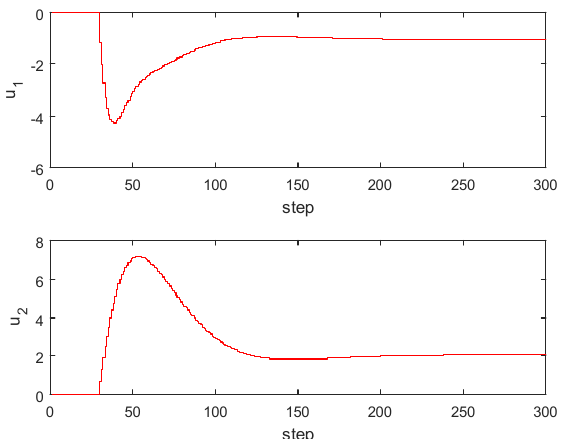
Figure 5. GPC with the 6th order internal model—closed loop simulation of 300 time-steps, trend for MVs signals.